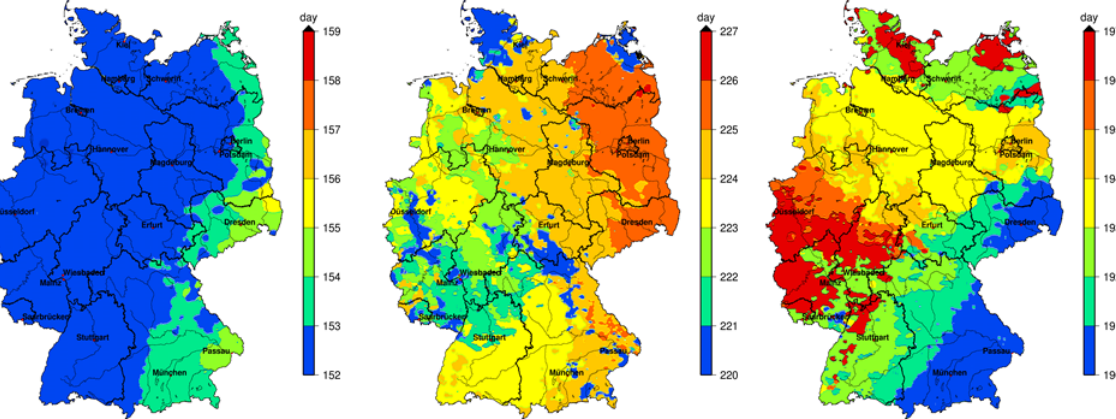
Figure 5. Day of the year at each REGNIE grid point where the event related maximum R3d total according to Fig. 4 occurred (end of the 3-day total) for June 2013 (left), August 2002 (middle) and July 1954 (right). The day 152 corresponds to 1 June, 220 to 8 August, and 190 to 9 July. The indicated days refer to the end of